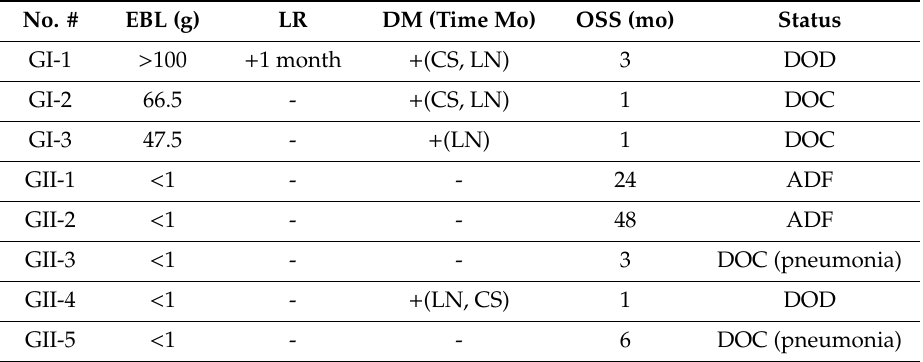
Table 2. Survival, bleeding loss, and metastasis for both GI and